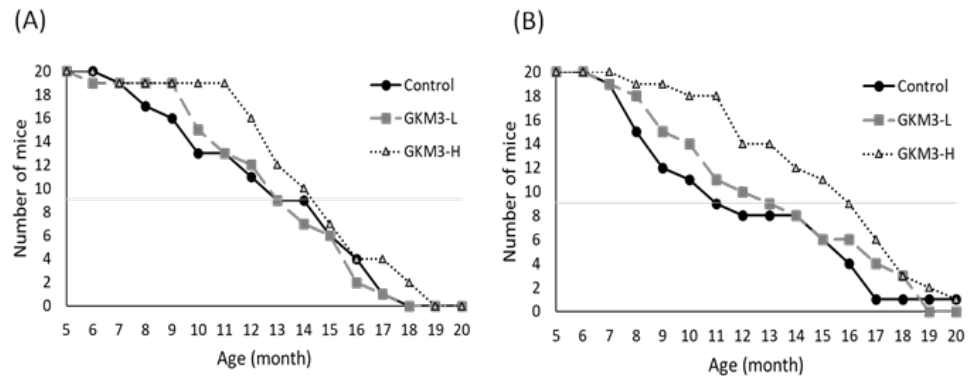
Figure 1. The lifespan of SAMP8 mice in males ( A ) and females ( B ). GKM3-L and GKM3-H were represent the groups fed probiotic GKM3 at the low dosage of 1.0 × 10 9 CFU/kg BW/day and the high dosage of 5.1 × 10 9 CFU/kg BW/day, respectively (n = 10).